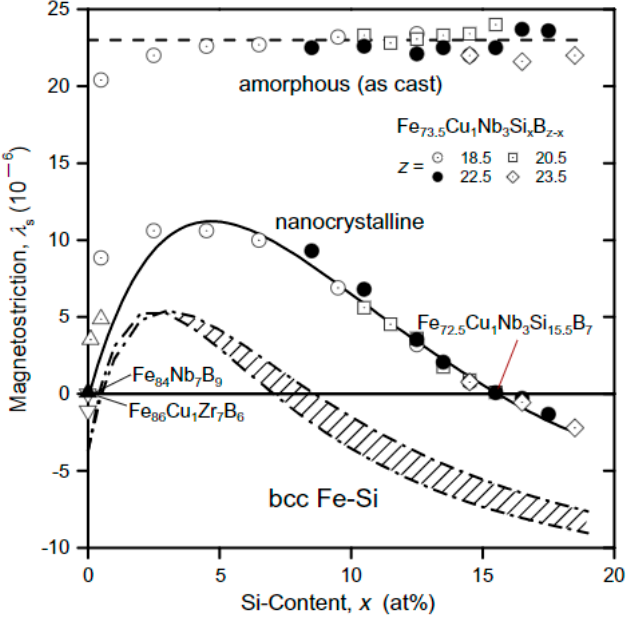
Figure 2. The saturation magnetostriction constant ( λ s ) of Fe 96 − z Cu 1 Nb 3 Si x B z − x alloys as a function of Si content for the amorphous and nanocrystalline states (reprinted with the permission from [23], Elsevier, 2013).